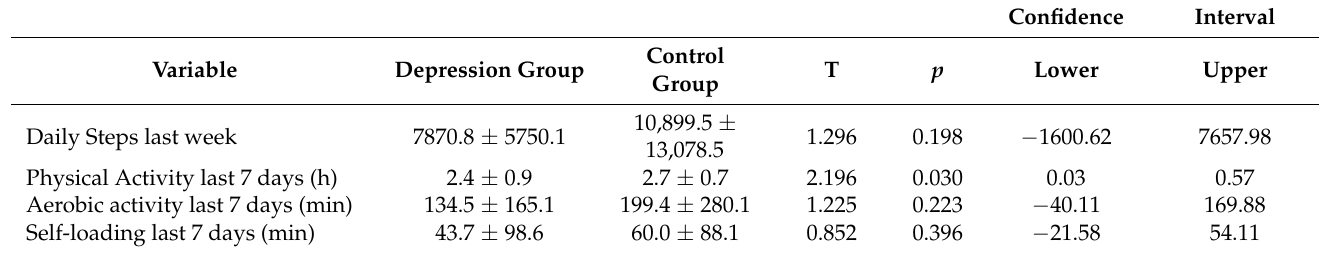
Table 5. Physical activity